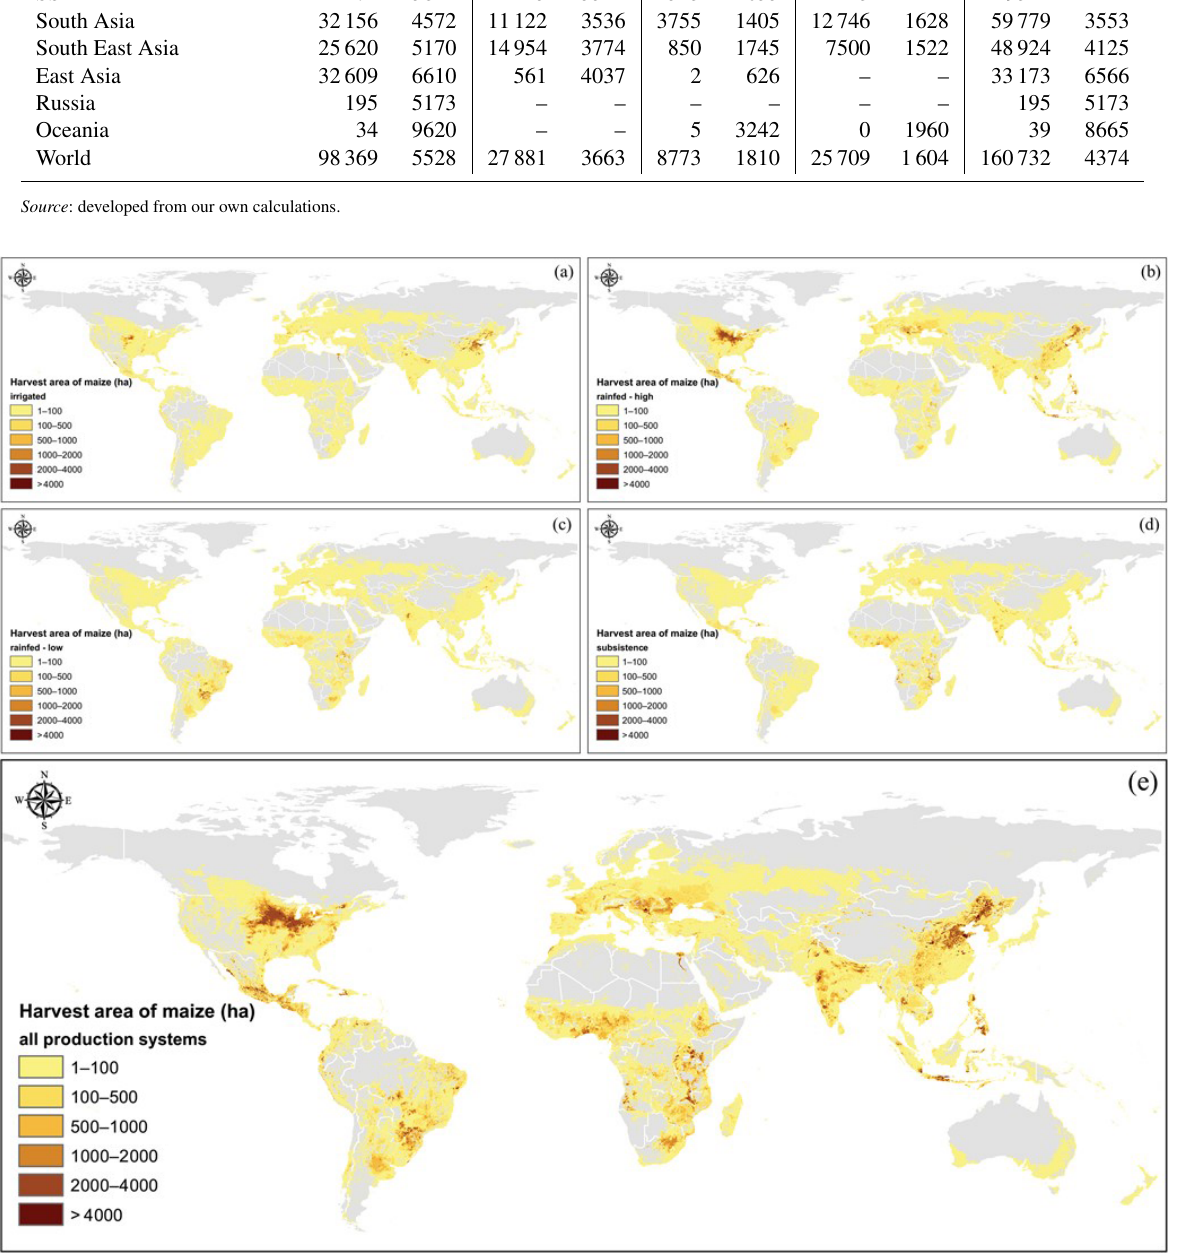
Figure 3. Harvested-area maps for maize in irrigated (a) , rainfed–high (b) , rainfed–low (c) , subsistence (d) , and all (e) farming